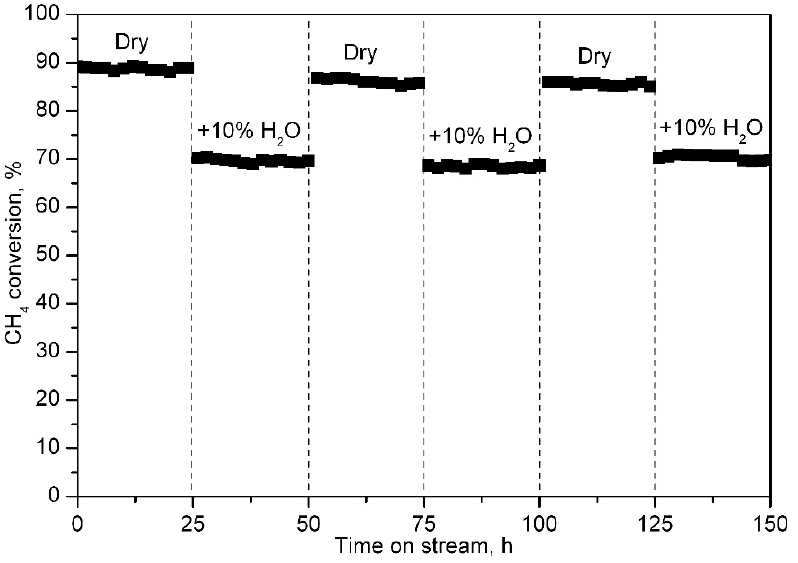
Figure 10. Evolution of methane conversion with time on stream over the CC catalyst under alter- nating dry/humid conditions at 500